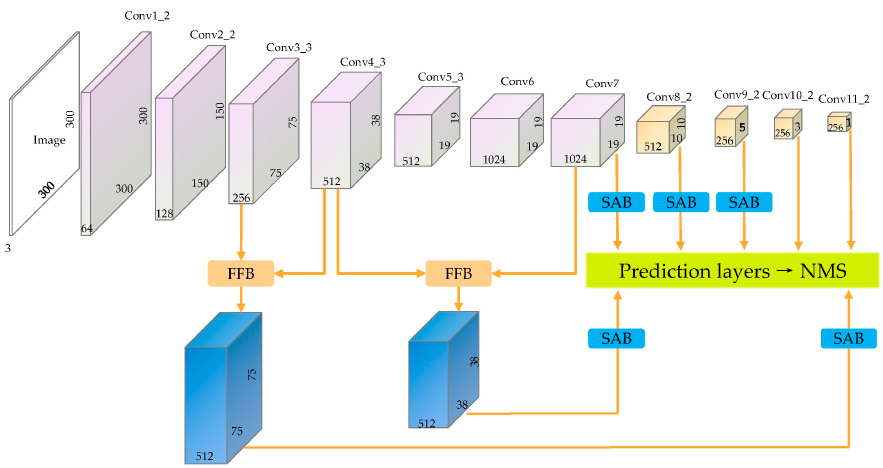
Figure 2. Schematic of the feature fusion and spatial attention-based single shot detector (FASSD)